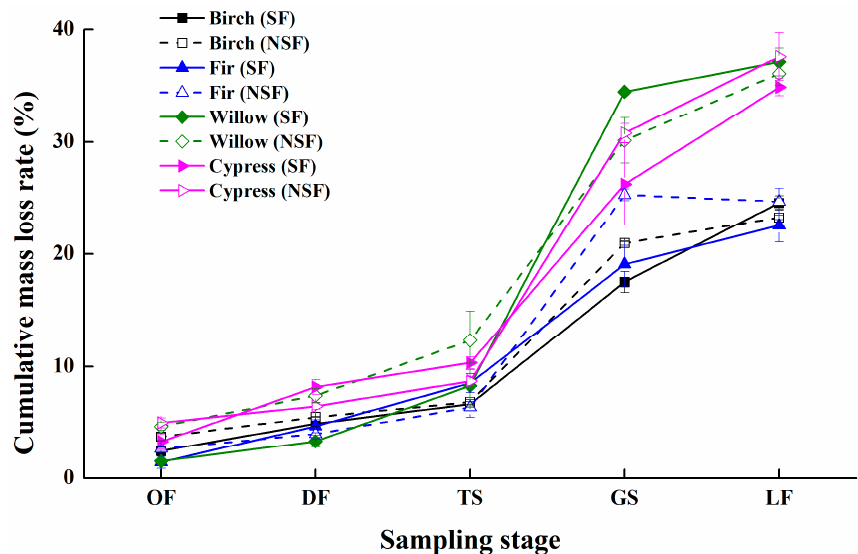
Figure 2. Cumulative mass loss rates of four litter (excluded (NSF) and non-excluded soil fauna (SF)) at different sampling stages (mean ± standard error, n = 3). OF: onset of freezing, DF: deep freezing stage, TS: thawing stage, GS: growing season, LF: leaf falling stage.